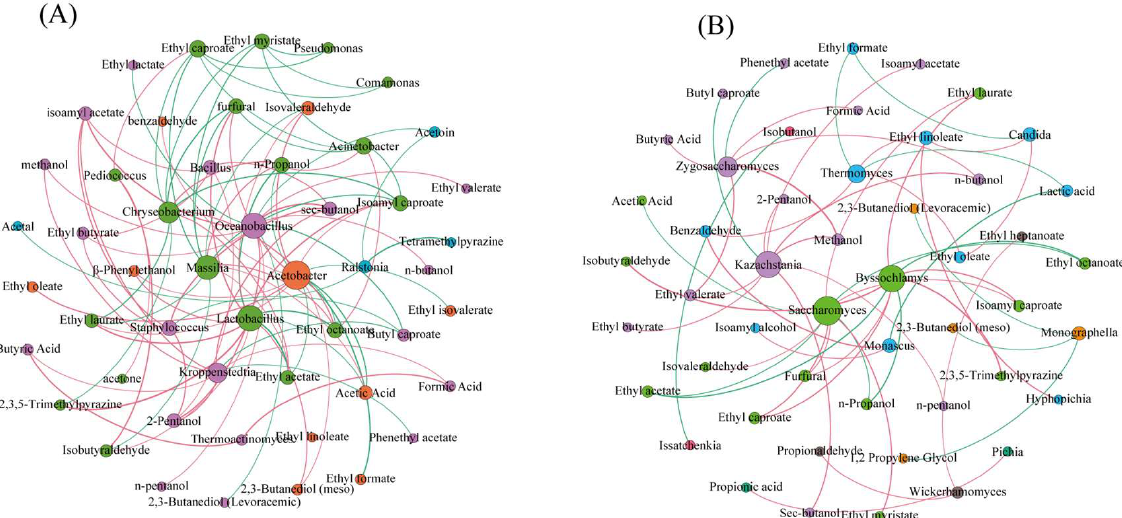
Figure 5. Correlation analysis of stacked microbial and base Baijiu flavor substances based on Spear- man’s correlation coefficient. ( A ) Correlation between bacteria and flavor substances. ( B ) Correlation between fungi and flavor substances. The size of the circles is linked to the number of the edge of compounds. The thickness of lines is proportional to the value of Spearman’s correlation (| ρ | > 0.6, p < 0.05). Red and green lines indicate negative and positive correlations between microbial and flavor substances.